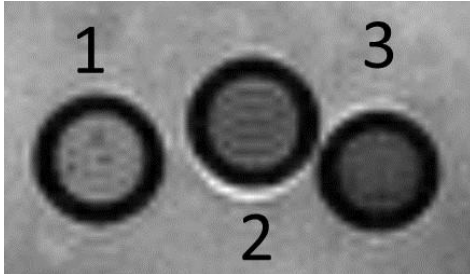
Figure 8. A T 2 -weighted RARE MR image recorded at 7 T of agar phantoms containing (1) HeLa cells; (2) Hela incubated for 24 h with H-ferritin (2) and HoS-ferritin (3). Unpublished data.